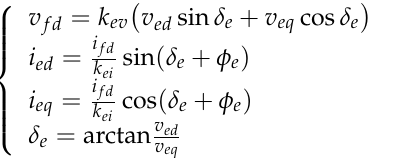
Figure 5. Linear model diagram of the exciter and rotating rectifier: ( a ) block diagram of the average model; ( b ) system space vector diagram.